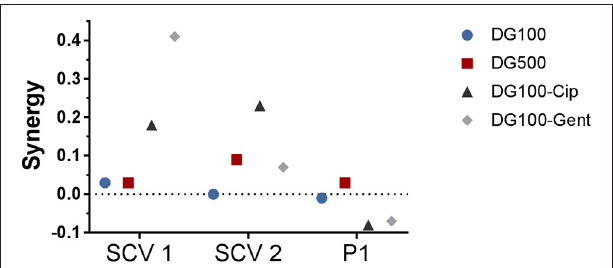
FIGURE 4 | Synergy of treatment combinations against small colony variant SCV1, SCV2 and parent strain P1 colony biofilms. Deferiprone 20 mM (Def)-Gallium-protoporphyrin (GaPP) 100 µ g/ml (blue circles), Def-GaPP500 µ g/ml (red squares), Def-GaPP100-ciprofloxacin 5 µ g/ml (black triangles), Def-GaPP100-gentamicin 100 µ g/ml (gray diamonds). The higher the value the higher the degree of synergy.